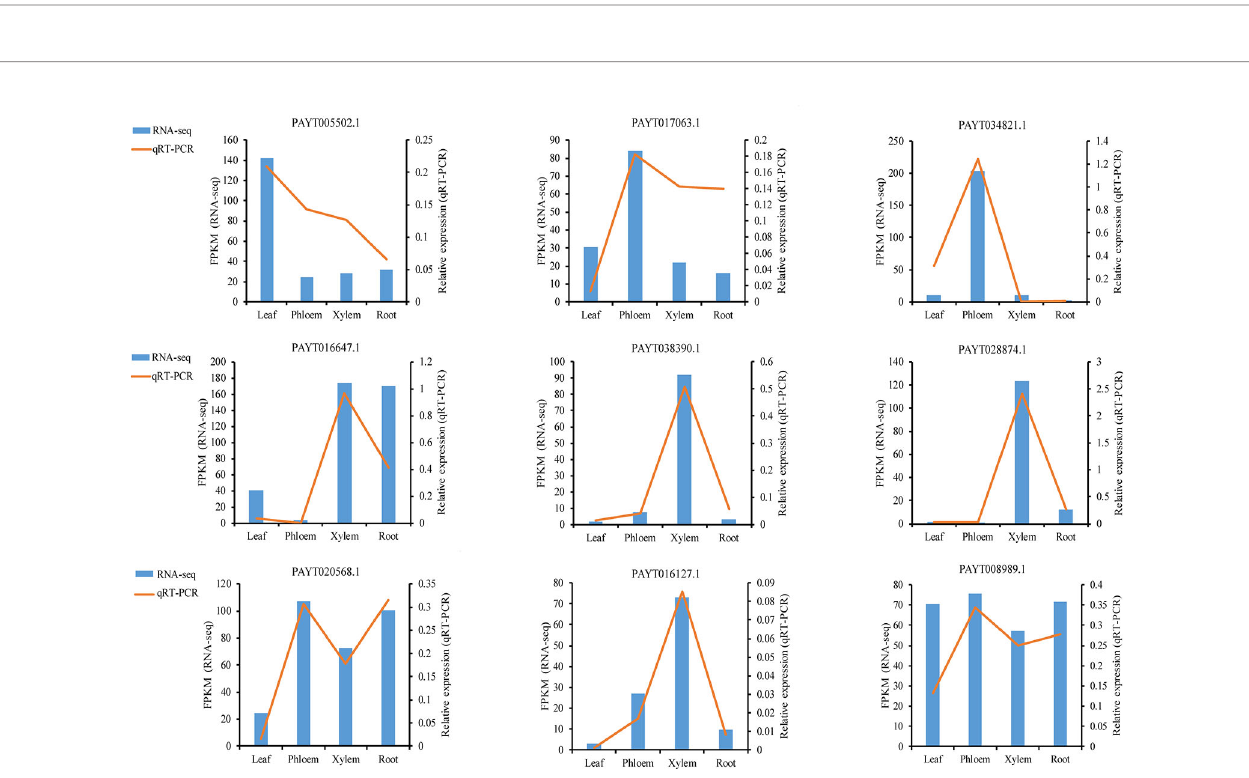
FIGURE 6 | qRT-PCR (quantitative real-time PCR) veri fi cation of nine selected genes. Comparison of RNA sequencing (RNA-Seq) data (blue bar) with qRT-PCR data (red line). The normalized expression levels (FPKM) from the RNA-Seq results are indicated on the y-axis to the left. The relative qRT-PCR expression level is shown on the y -axis to the right. Actin was used as an internal control. Both methods agree with each other in showing similar gene expression trends.